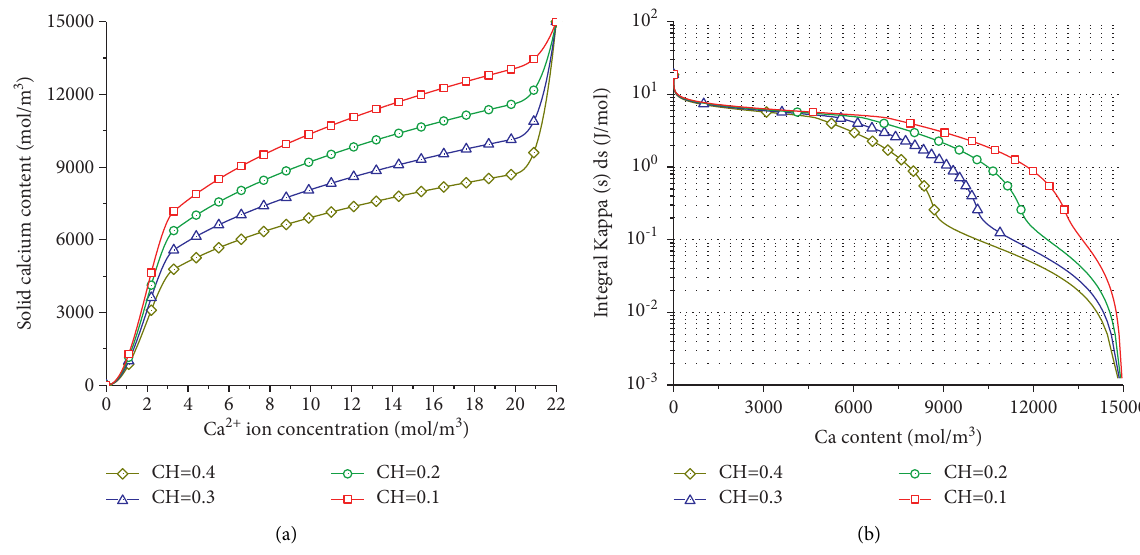
Figure 4: (a) Solid-liquid equilibrium curve with different CH contents. (b) 􏽒 S Ca